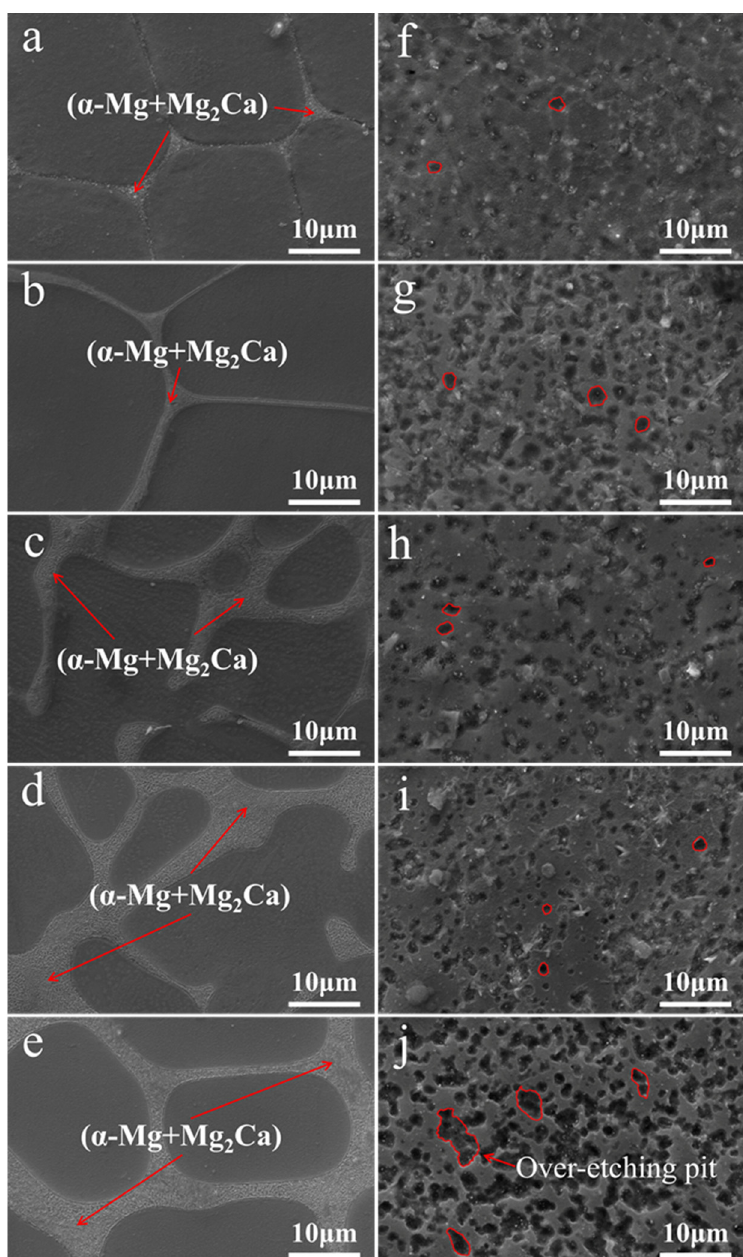
Figure 3. SEM images of Mg-In-Ca alloys: ( a ) as-cast IC31 alloy, ( b ) as-cast IC32 alloy, ( c ) as-cast IC33 alloy, ( d ) as-cast IC34 alloy, ( e ) as-cast IC35 alloy, ( f ) extruded IC31 alloy, ( g ) extruded IC32 alloy, ( h ) extruded IC33 alloy, ( i ) extruded IC34 alloy, and ( j ) extruded IC35